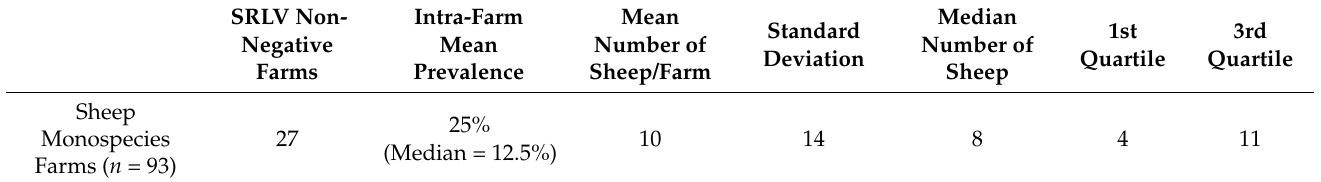
Table 4. Descriptive statistics of SRLV results for the 93 sheep monospecies farms.